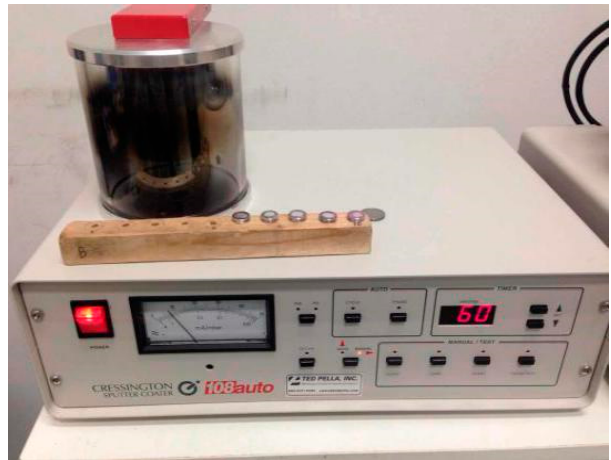
Figure 5. Field-emission scanning electron microscope.